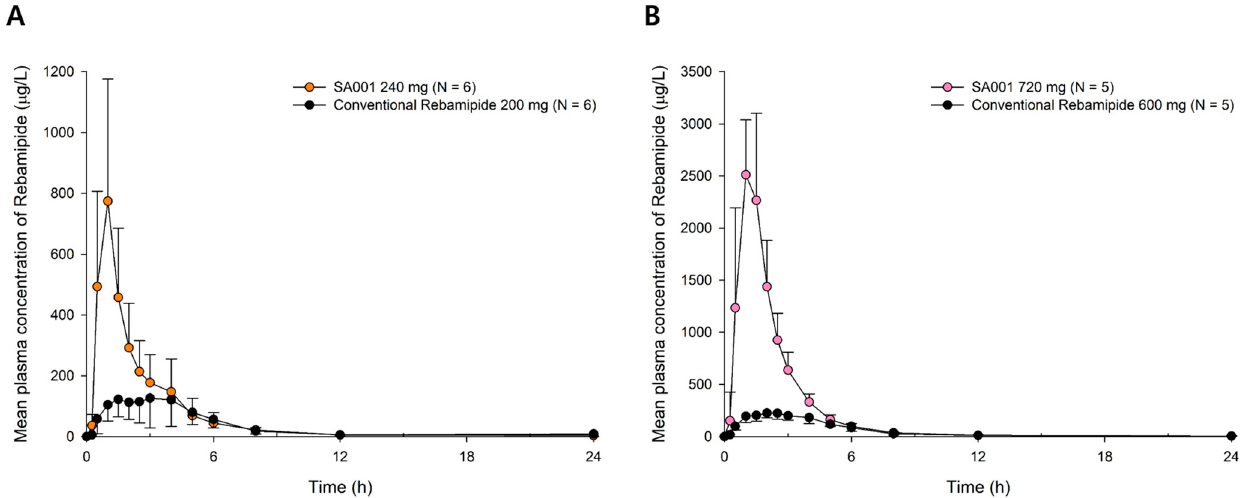
Figure 2. Mean plasma concentration-time profiles of rebamipide after single oral administration of SA001 and conventional rebamipide (Bamedin ® ) ( A ) SA001 240 mg and conventional rebamipide 200 mg ( B ) SA001 720 mg and conventional rebamipide 600 mg. Bars represent standard deviations. Table 3. Pharmacokinetic parameters of rebamipide after single oral administration of SA001 and conventional rebamipide (Bamedin ® ).